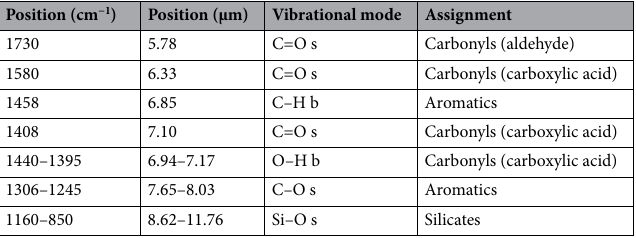
Table 1. Spectral positions and assignments of the organic matter and inorganic silicates observed via nano- FTIR spectroscopy. s stretching, b bending.